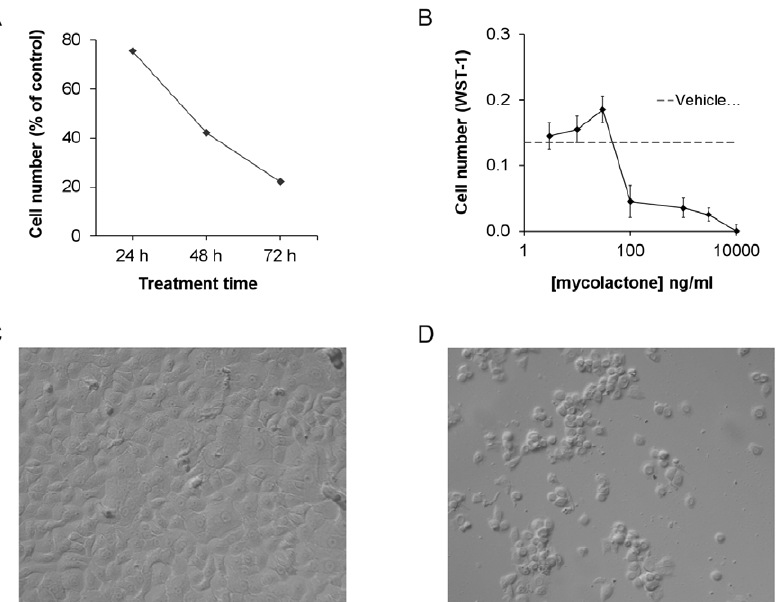
Figure 1. Mycolactone is cytotoxic for keratinocytes. Mycolactone was added to sub-confluent cultures of keratinocytes and (A) cell numbers were measured as optical density of WST-1after 24, 48 and 72 h of treatment with 1000 ng/ml of mycolactone, or (B) after 72 h at different concentrations of mycolactone. An asterisk indicates a significant (p , 0.05) reduction in WST-1 labeling as compared to the corresponding medium control. Cell cultures of untreated controls (C) and cultures treated with 300 ng/m mycolactone (D) were photographed after 48 h. Data are from one representative experiment showing means and SD of triplicates.